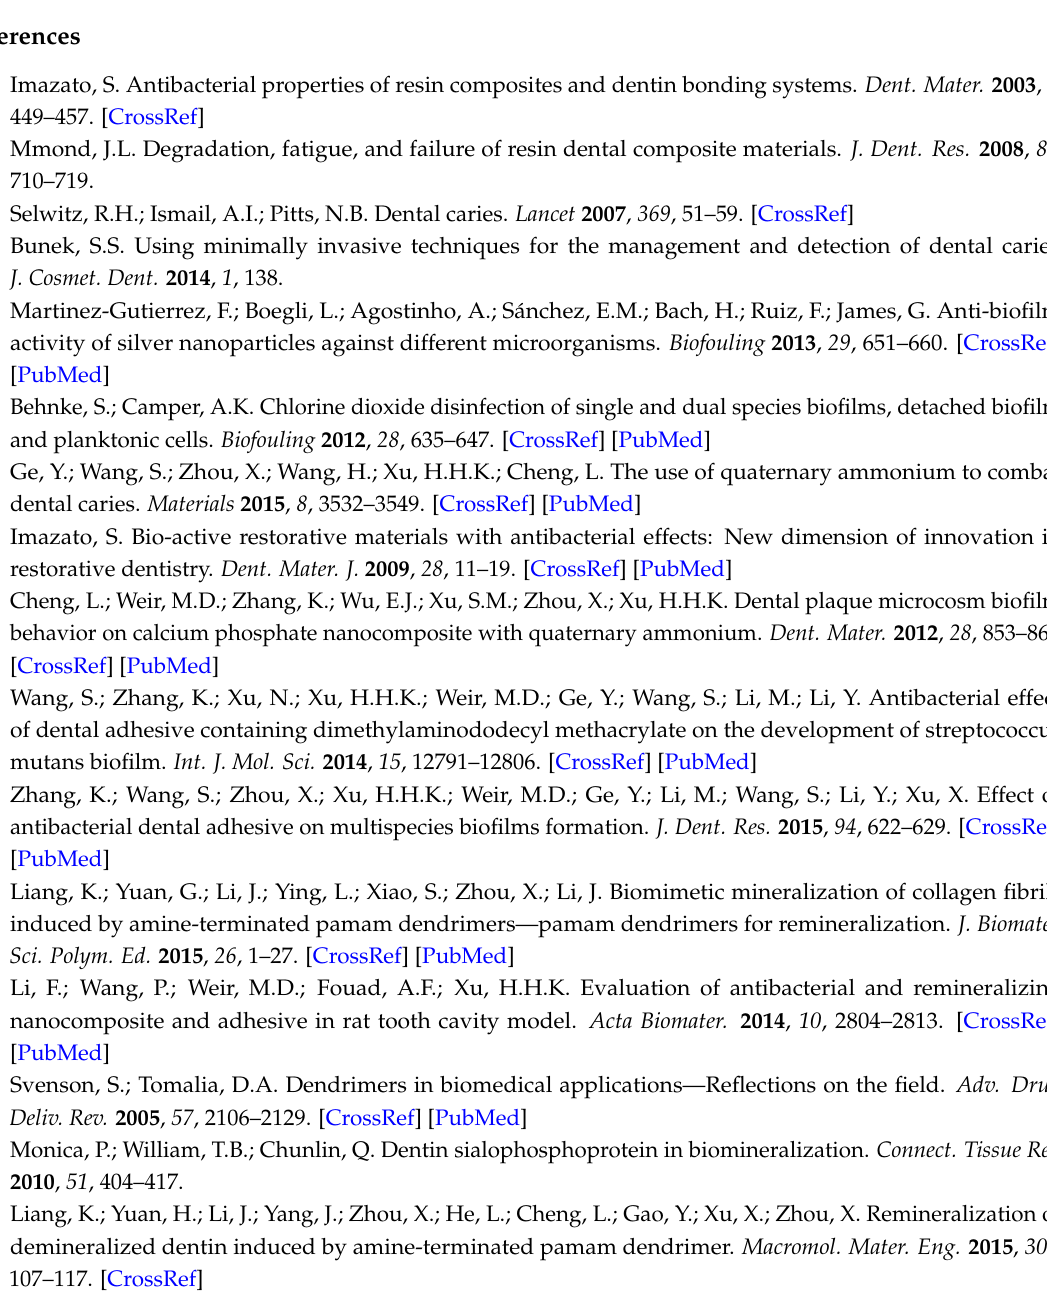
Figure S1: The standard curve plotted by known concentration of DNA of three species bacteria; Table S1: The sequences of primers and probes used in the